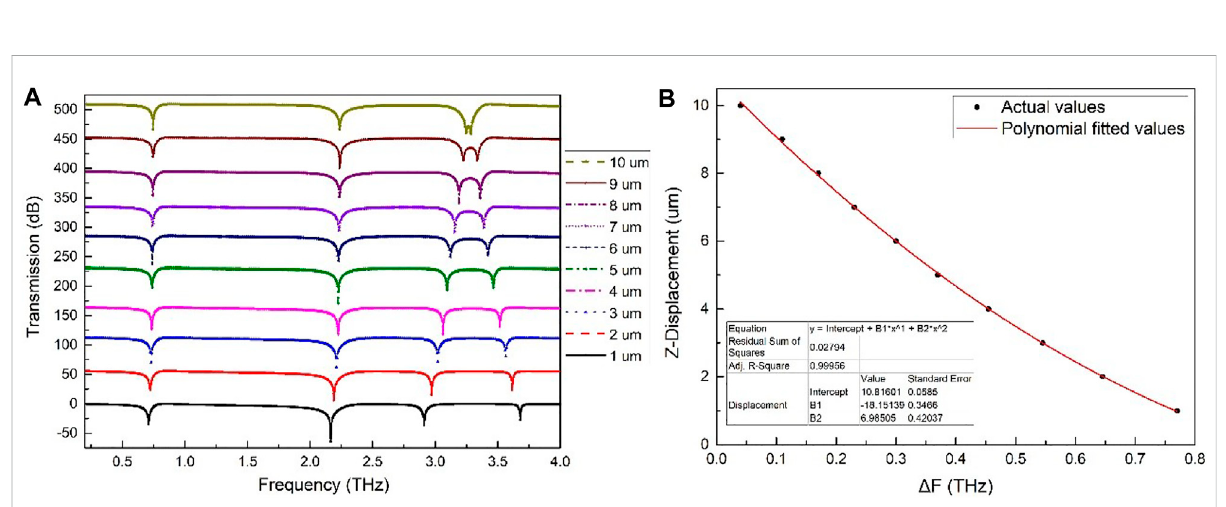
FIGURE 7 The z displacement measurement method for the THz displacement sensor. (A) Transmission spectra of the proposed THz-DS with different z displacement. (B) The relationship diagrams between the z displacement and the Δ F.